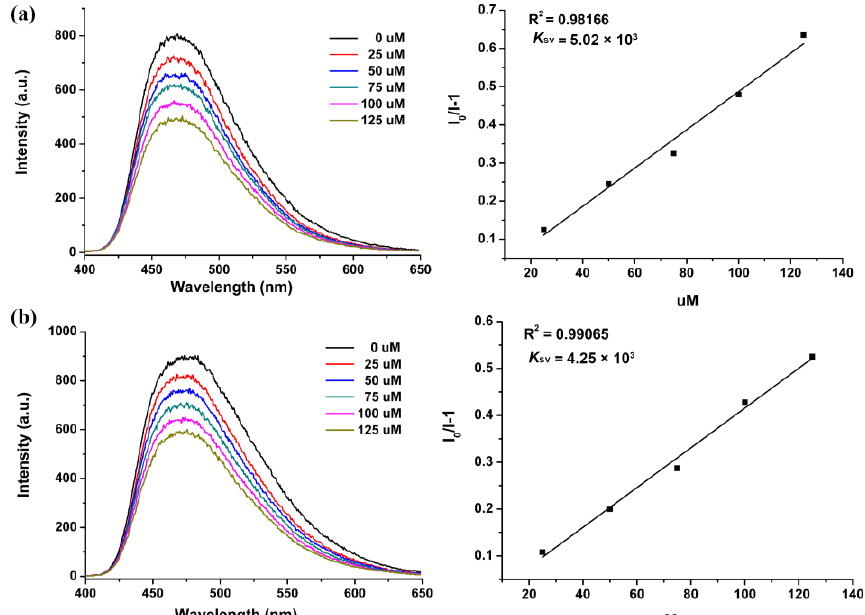
Figure 5. ( a ) FL spectra of Sr 2 (tcbpe) dispersed in 0.5 × 10 − 2 M Na + aqueous solutions by adding Fe 3+ ions at various concentrations and the corresponding K sv curve. ( b ) FL spectra of Sr 2 (tcbpe) dispersed in 0.5 × 10 − 2 M Ca 2+ solutions with the addition of Fe 3+ ions and the corresponding K sv curve.